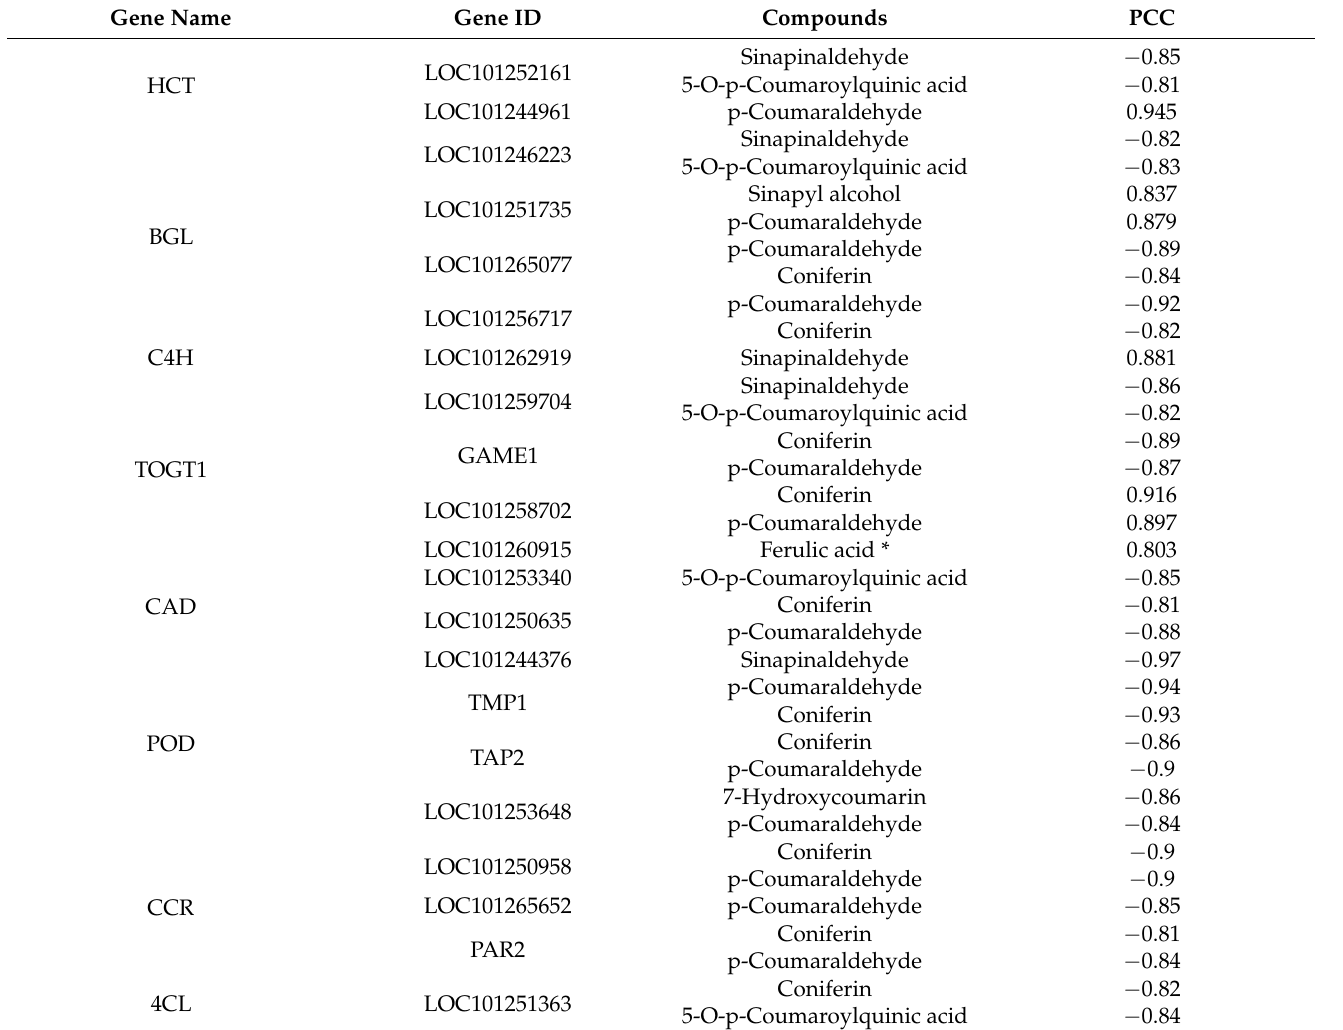
Table 4. Result of phenolic-acid correlation network